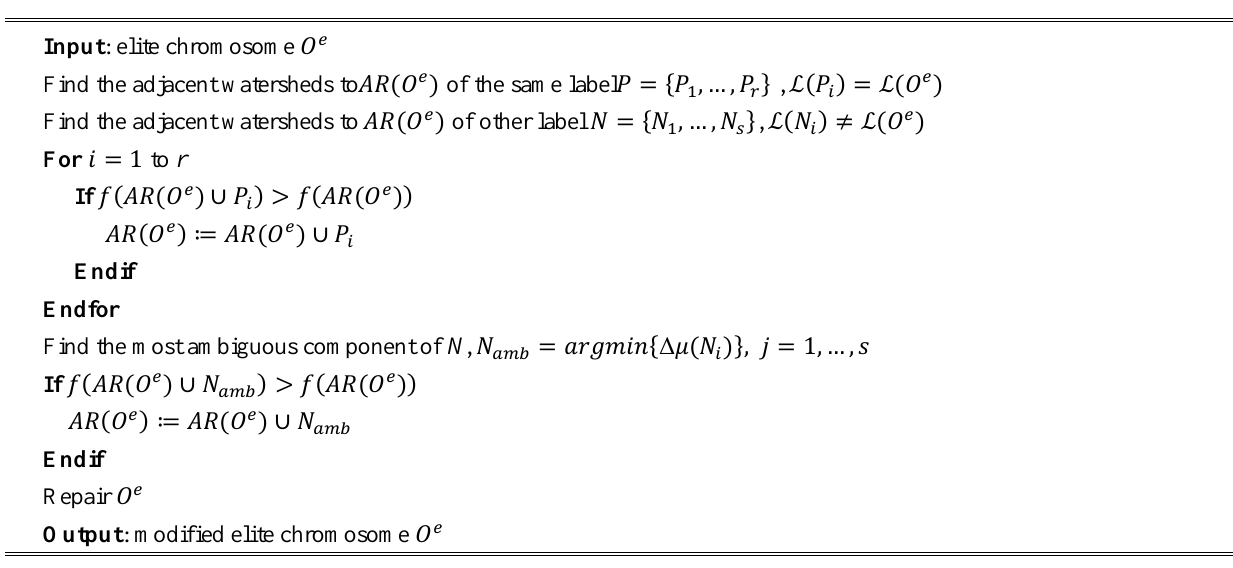
Figure 6. Description of the elite tuning